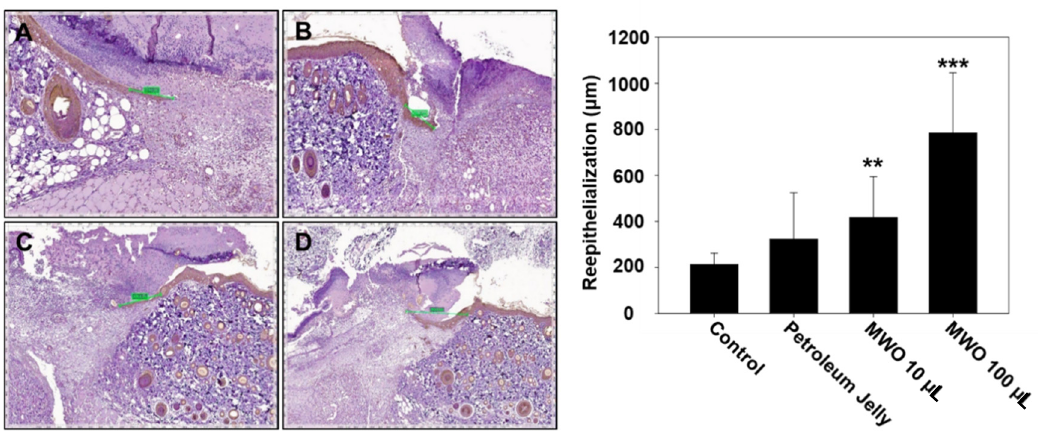
Figure 7. Effect of MWO on re-epithelialization in skin wounds of rats. The tissues harvested from the skin wound area of rats treated with or without MWO were used in immunohistochemistry staining with anti-pan-cytokeratin for re-epithelialization. Immunohistochemistry staining with anti-pan-cytokeratin is represented by the brown color (magnification × 12.5). The values are shown as means ± SD. ** p < 0.01 and *** p < 0.001 compared to the control. ( A ) The skin wound area untreated with MWO. ( B ) Treated with petroleum jelly as a negative control. ( C ) Treated with 10 µ L MWO. ( D ) Treated with 100 µ L MWO.